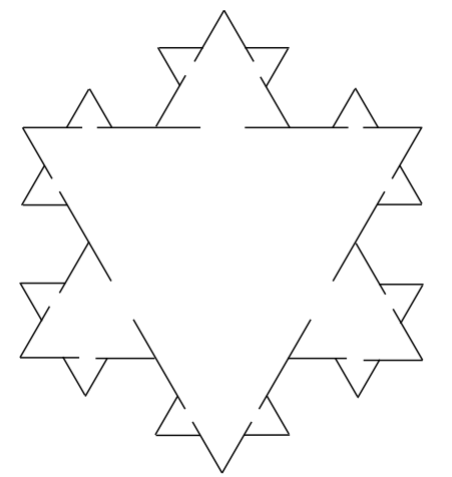
Figure 6. The modified Koch domain (pre-fractal, second step) introduced in [28]. The passage between triangles is blocked by a wall with a small opening. The construction can be considered for random Koch domains. The time the process spends in a triangle strongly depends on the size of the opening. The asymptotic behavior of that size implies the construction of trap or non-trap Koch